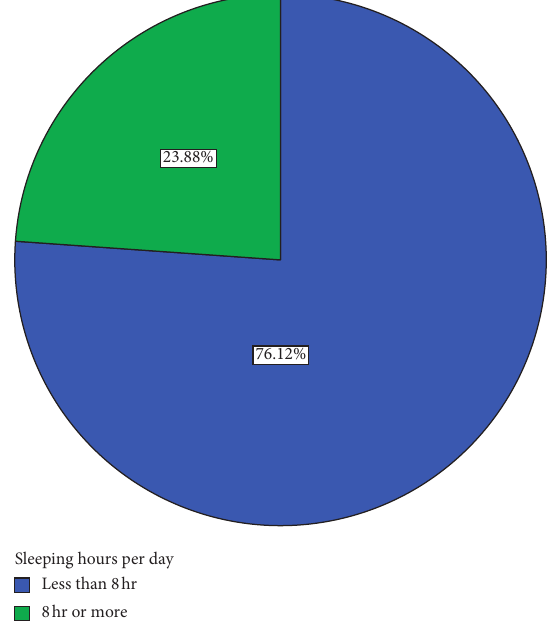
Figure 8: Distribution of sleeping hours per day of